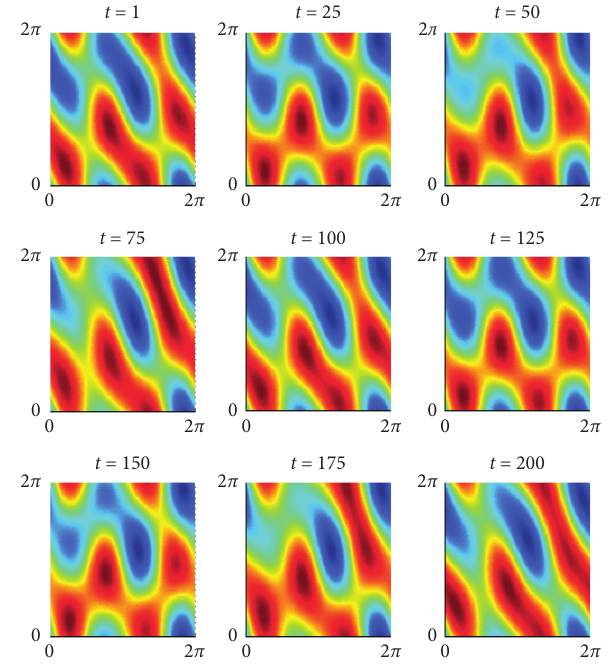
Figure 2: The vorticity of each of the four asymptotically stable fixed point corresponding to the laminar regime at R � (− 1 , 0 . 5 , 0 . 7 , 2 . 5 , 0 . 1 , 3 . 5 , − 0 . 4 ) ; (b) x T initial conditions: (a) x T 0 − 3 . 5 , 0 . 4 ) ; (d) x T � ( 1 , 0 . 5 , 0 . 7 , − 2 . 5 , 0 . 1 , − 3 . 5 , 0 . 4 ) . 0